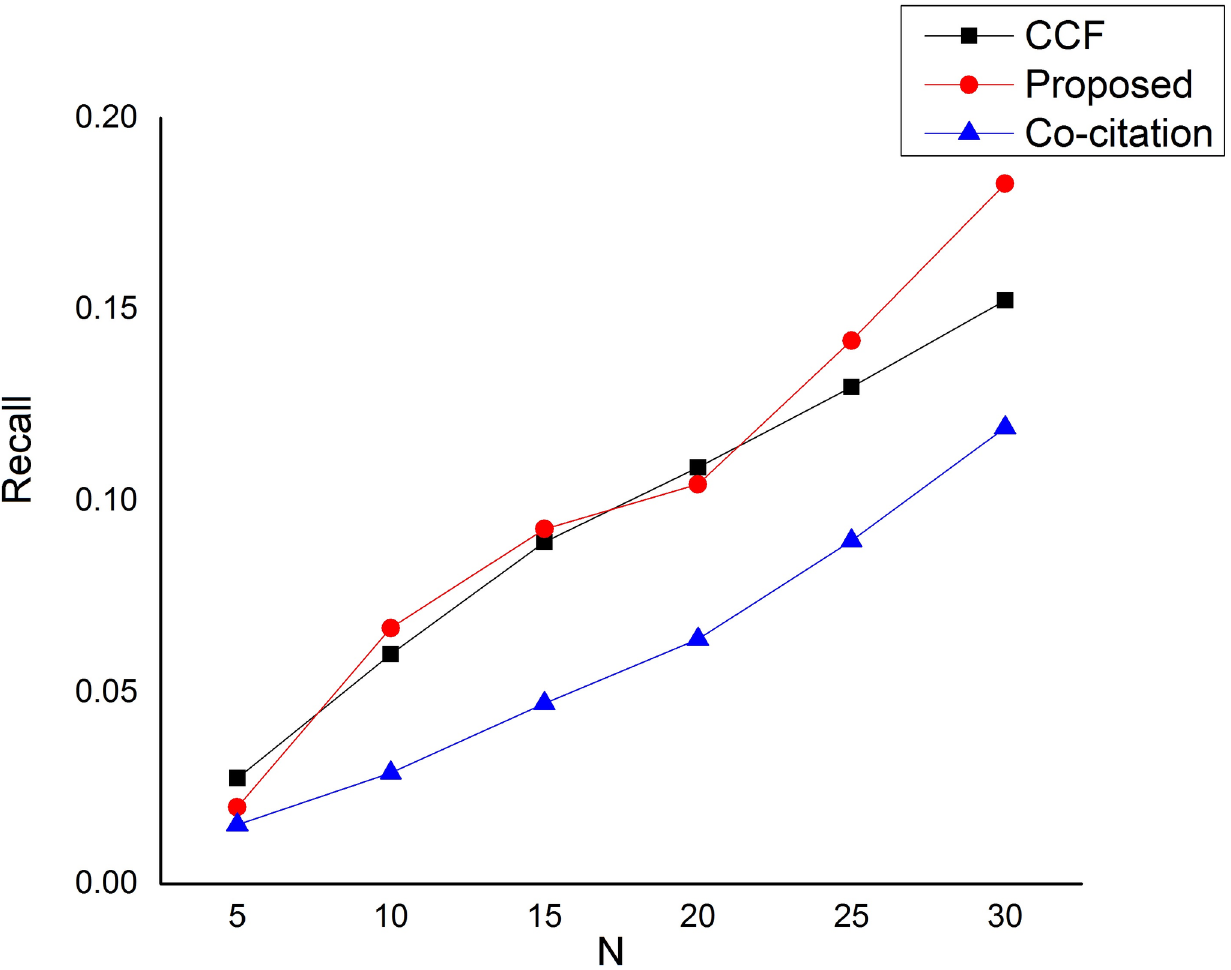
Fig 3. Recall performance on the